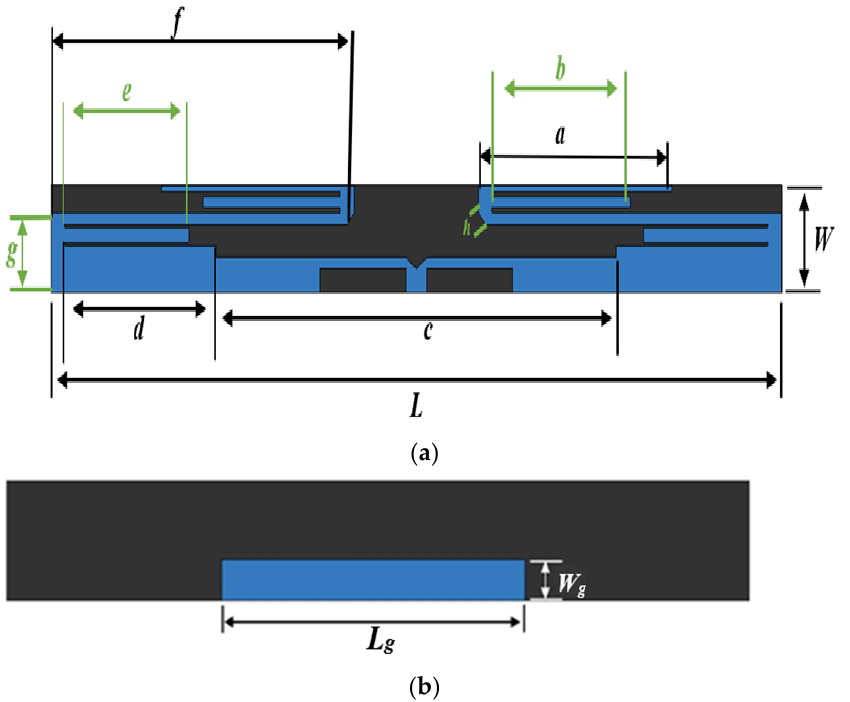
Figure 1. Geometry of the simulated monopole antenna design. ( a ) Front view and ( b ) back view.